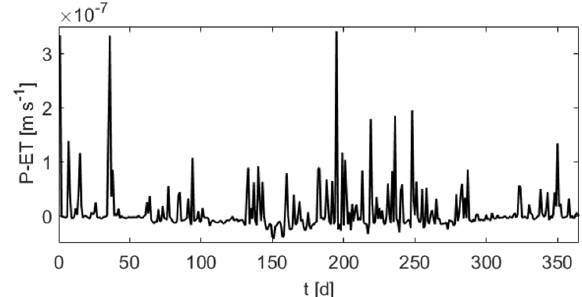
Figure 4. Net precipitation and evapotranspiration used for the 1D flow model. Positive values indicate inflow and negative values out-